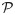
Local analysis of the independence statistical symmetry for the currency pair USD/JPY in the week from 2011, October, 30th to 2011, November, 5th.(a-1) Mid-quote time series in tick time with intervals evaluated as independence asymmetric shown in green (for window size w = 1000). (a-2) Color plot showing window size effect on the hypothesis test; color code refers to the decimal logarithm of the probability P and points are colored only if P is below the threshold 10−7, i.e., if they are classified as independence asymmetric. (b-1) and (b-2) details the Japanese government intervention; red box indicates the quick increase in the mid-quote and the blue box the period of almost constant mid-quote. The period corresponding to the increase in the mid-quote is classified as independence symmetric and the almost constant period, independence asymmetric.